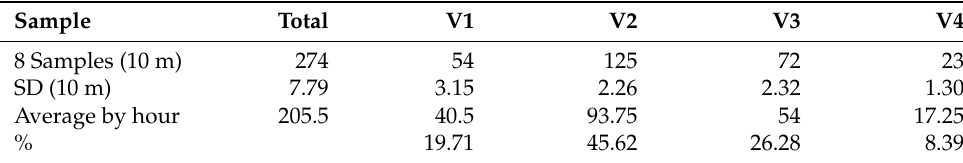
Table 8. Matagalls Street sample resume, square with Malats